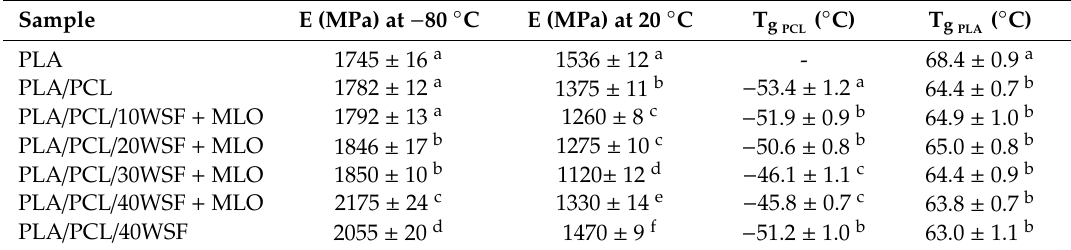
Table 5. Main thermomechanical parameters of the green composites made of polylactide (PLA), poly( ε -caprolactone) (PCL), walnut shell flour (WSF), and maleinized linseed oil (MLO) in terms of: storage modulus (E’) measured at − 80 ◦ C and 20 ◦ C and glass transition temperature (T g ) for the PLA and PCL